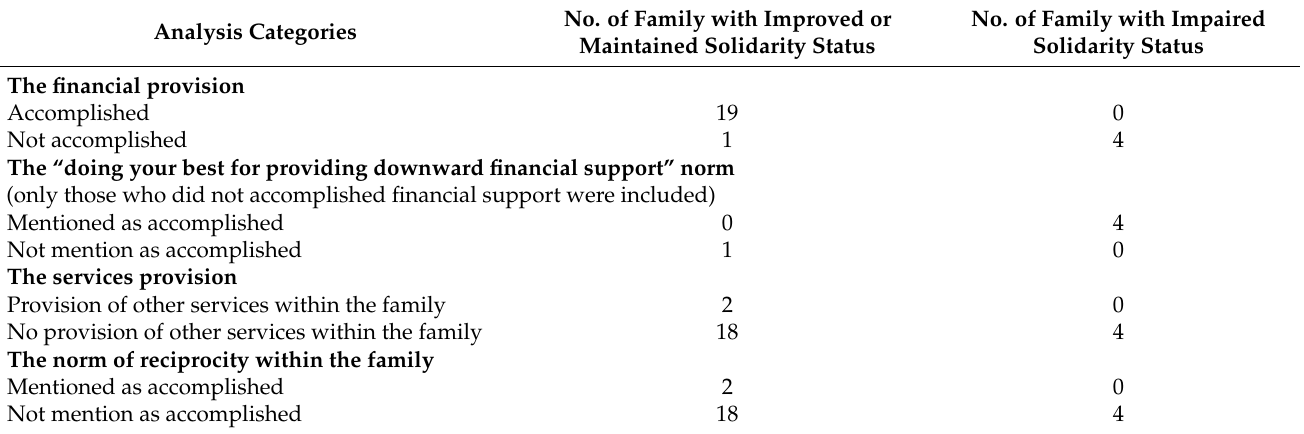
Table 2. The material support and the feeling of unity with the